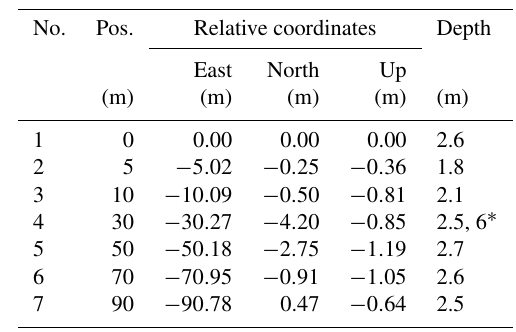
Table 1. Measurement holes. Coordinates are given in the UTM co- ordinate system relative to hole 1 that is located at 32T: